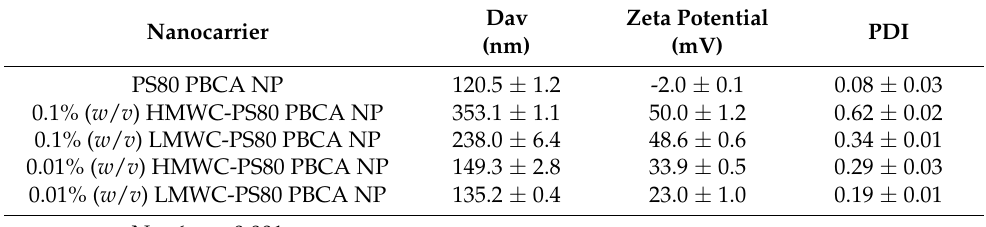
Table 1. The average diameter (Dav), zeta potential, and polydispersity index (PDI) of the nanoparticles.